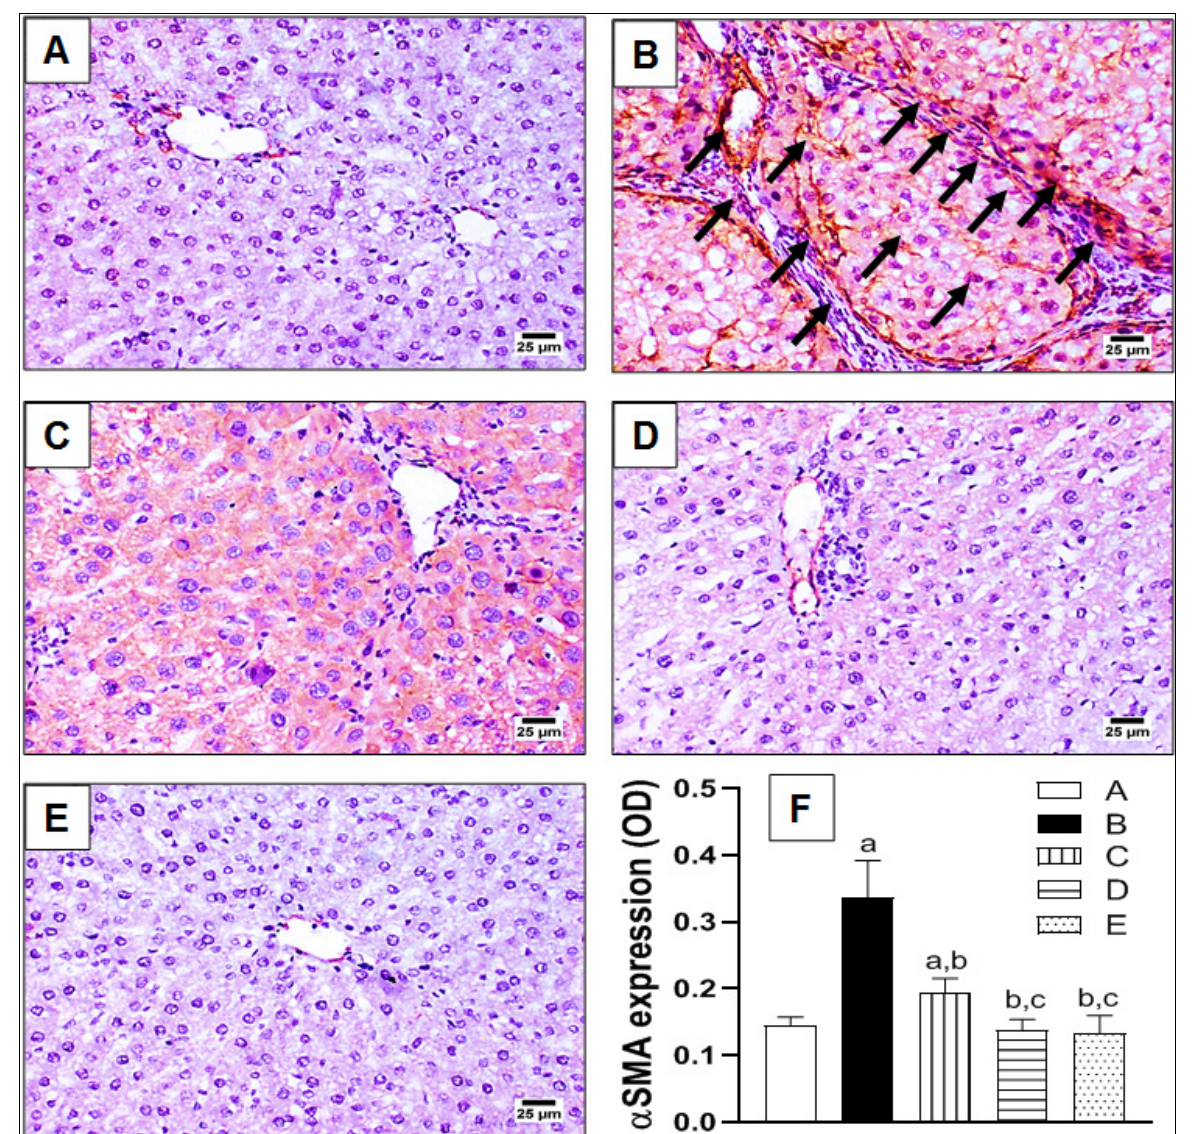
Figure 3. The effect of lycorine on expression of α smooth muscle actin ( α SMA) by immunohisto- chemical staining in a rat model of TAA-induced liver fibrosis. ( A ) Control group; ( B ) TAA-challenged group; ( C , D ) lycorine-treated groups at doses 0.5 and 1.0 mg/kg, respectively; ( E ) lycorine-alone group; ( F ) quantitative image analysis for α SMA immunohistochemical staining, as optical density (OD) across six different fields. Data are presented as mean ± S.D. ( n = 6). (a), (b), (c) Statistically significant from the control, TAA, and TAA + lycorine 0.5 mg/kg/d groups, respectively, at p < 0.05 using one-way analysis of variance (ANOVA) followed by Tukey’s as a post- hoc test.